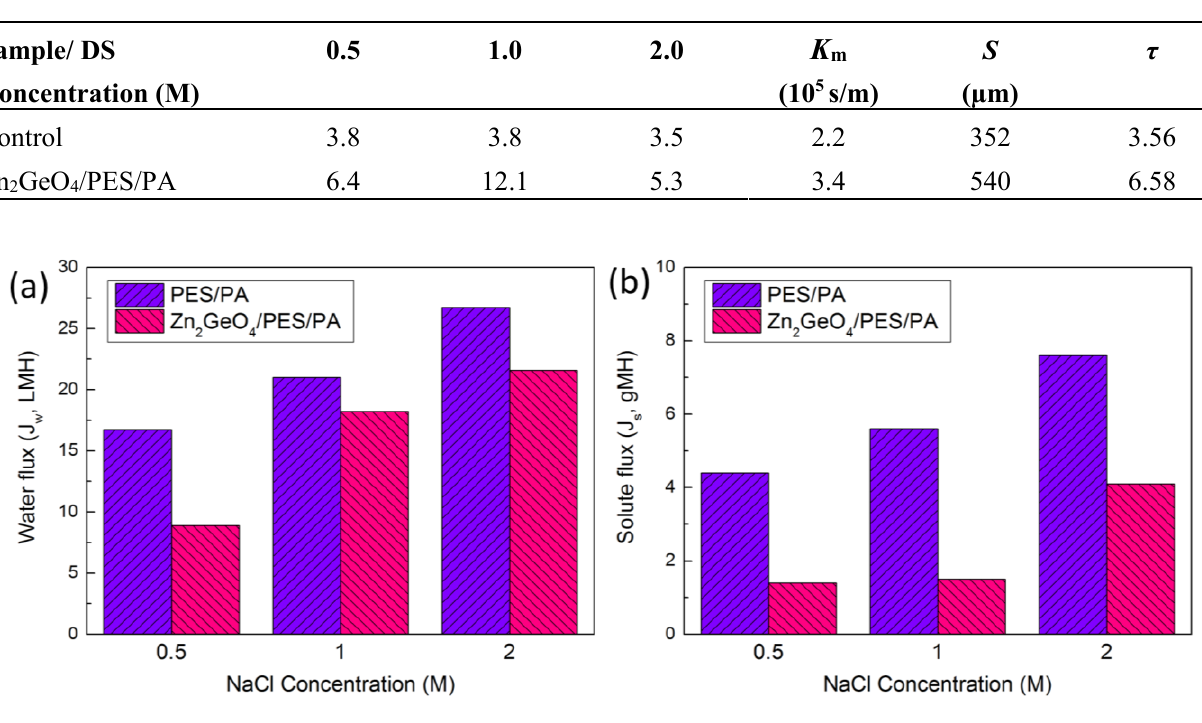
Figure 4. ( a ) FO water flux; ( b ) solute flux of pristine membrane and Zn 2 GeO 4 /PES/PA membrane using NaCl at different concentration (orientation: active-layer-facing-FS